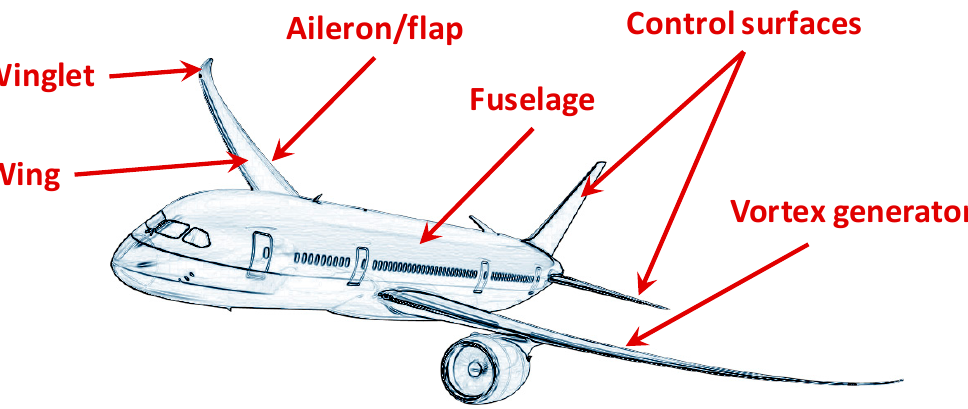
Figure 1. Locations of adaptive aerodynamic applications in the aeronautical field.